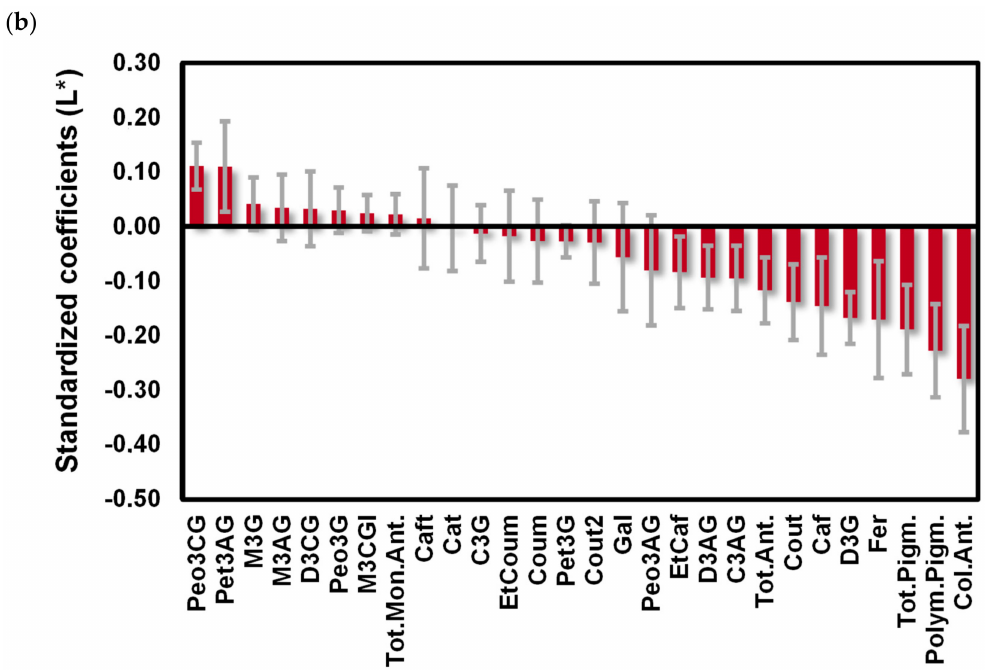
Figure 8. Calibration curves obtained after PLS regression of the L* values of ‘Menc í a’ / ‘Jaen’ wines using the phenolic composition and colorimetric determination of colored anthocyanins, polymeric pigments, total pigments, total anthocyanins as independent variables (black circles calibration samples, red circles test samples) ( a ) and B coefficients plots ( b ). Delphinidin-3-glucoside (D3G), cyanidin-3-glucoside (C3G), peonidin-3-glucoside (Peo3G), petunidin-3-glucoside (Pet3G), malvidin-3-glucoside (M3G), delphinidin-3-acetylglucoside (D3AG), cyanidin-3-acetylglucoside (C3AG), peonidin-3-acetylglucoside (Peo3AG), petunidin-3-acetylglucoside (Pet3AG), malvidin-3-acetylglucoside (M3AG), delphinidin-3-coumaroylglucoside (D3CG), peonidin-3-coumaroylglucoside (Peo3CG), malvidin-3-coumaroylglucoside (M3CG), gallic acid (Gal), caftaric acid (Caft), coutaric acid (Cout), coutaric acid isomer (Cout2), caffeic acid (Caf), coumaric acid (Coum), catechin (Cat), ethyl ester of caffeic acid (EtCaf), ethyl ester of coumaric acid (EtCoum), total monomeric anthocyanins (Tot.Mon.Ant.), total pigment (Tot.Pigm.), polymeric pigments (Polym.Pigm.), colored anthocyanins (Col.Ant.), total anthocyanins measured colorimetrically